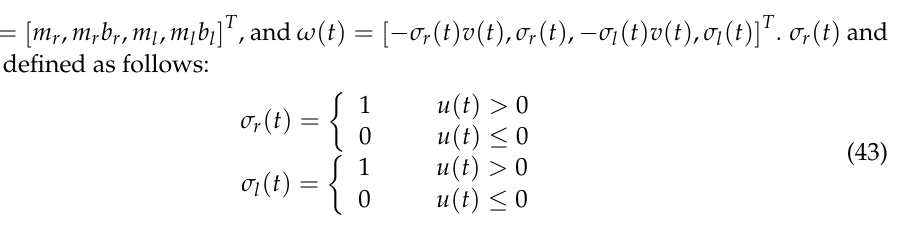
Figure 6. Smooth dead-zone inverse curve.